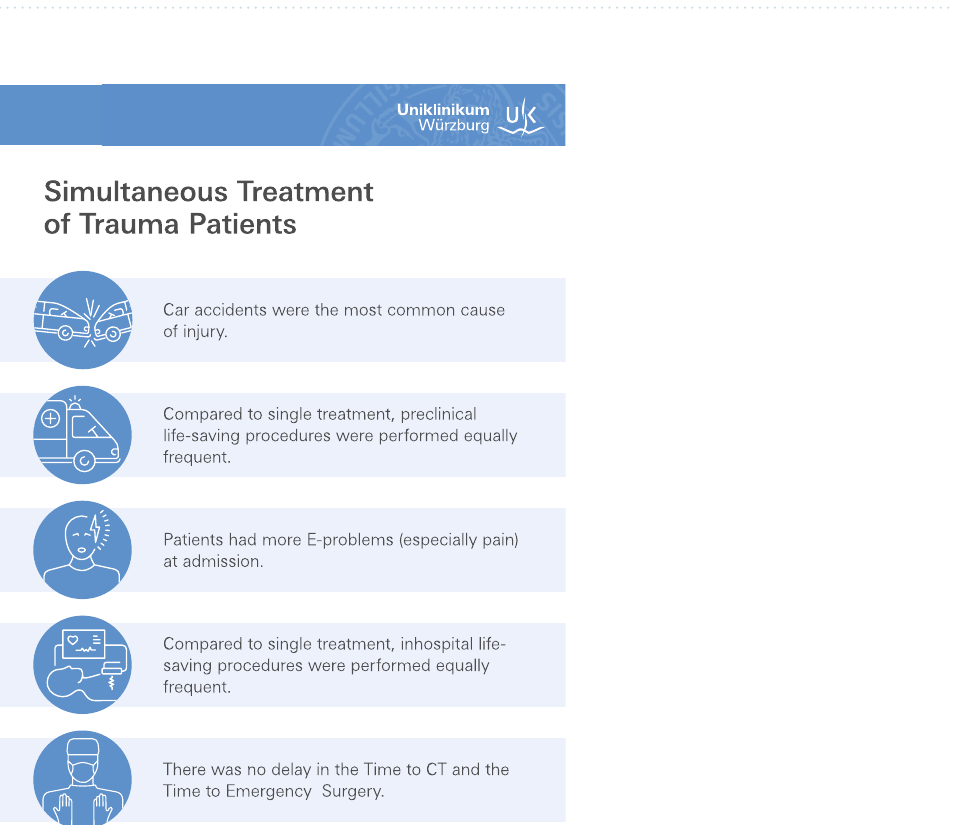
Table 6. RISC-II-Score and observed mortality.